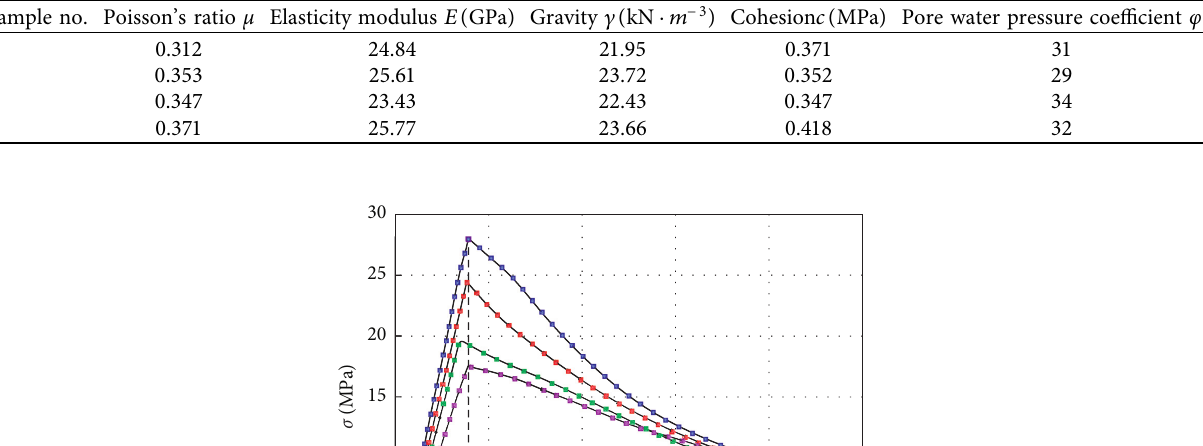
Table 1: Rock test results.